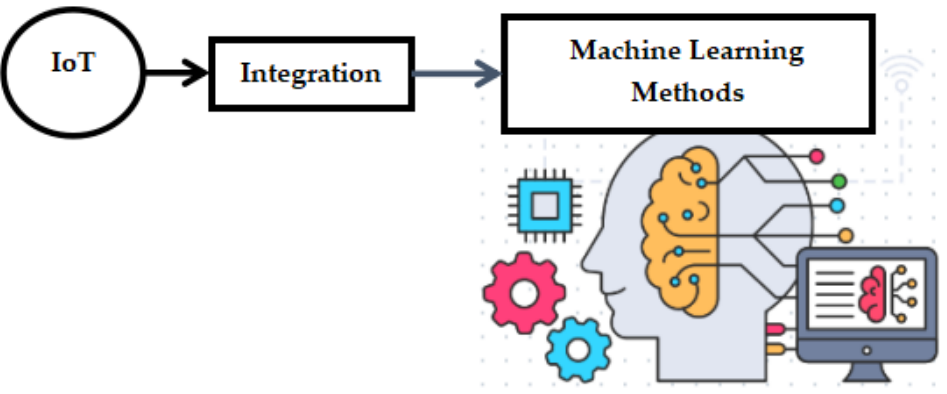
Figure 4. Integrating IoT technology and machine learning into SG increases energy efficiency [45].